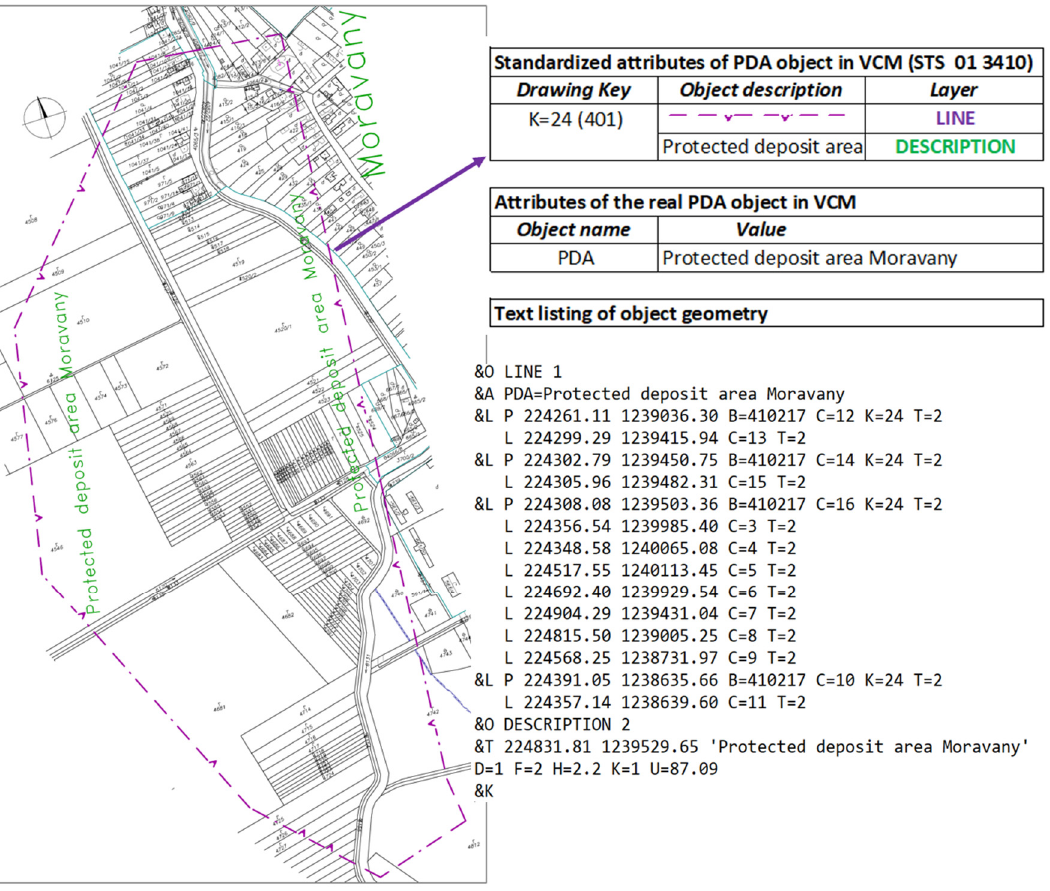
Figure 4. Example of geometric and attribute representation of the boundary of the PDA c.u. Moravany.